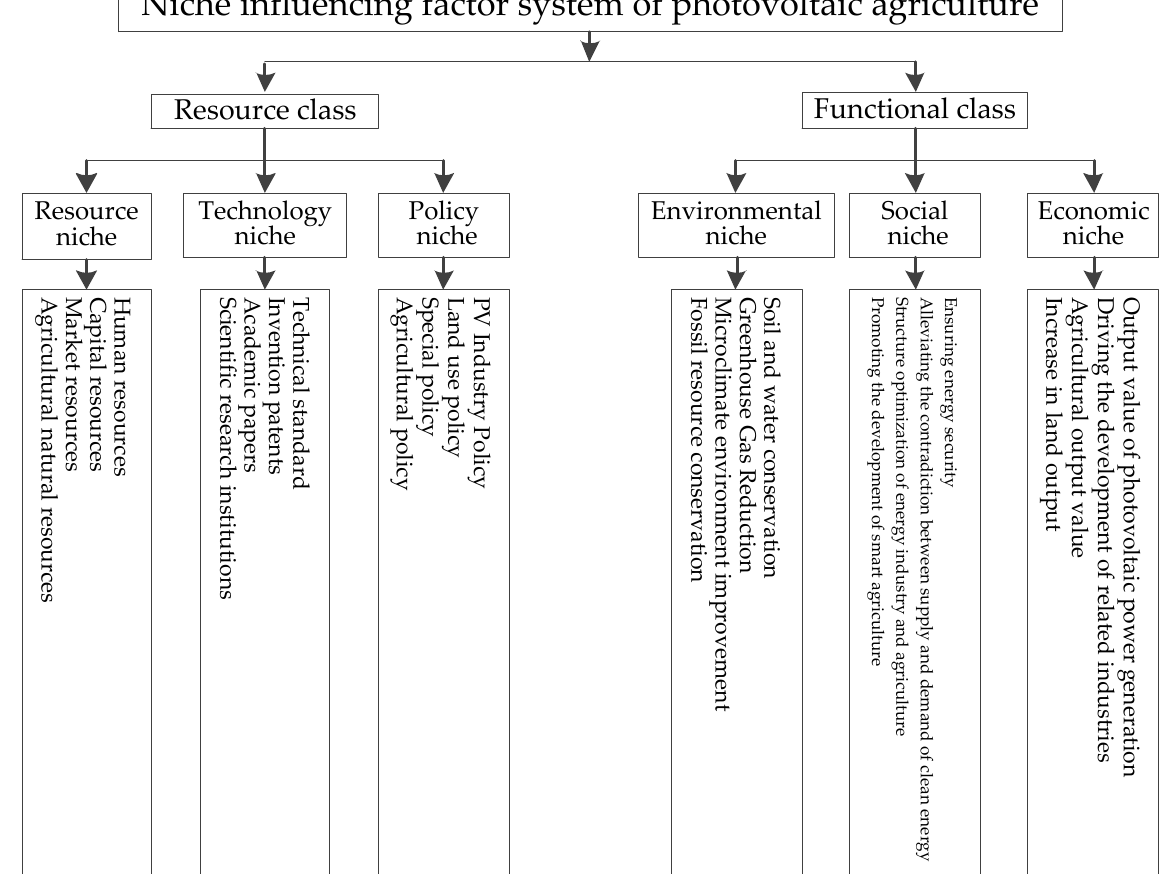
Figure 1. Analytical framework.